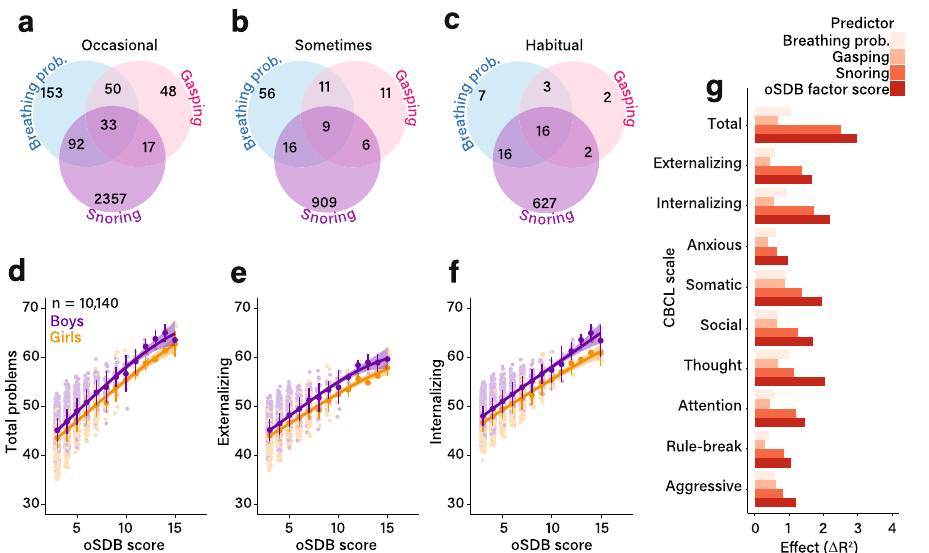
Fig. 1 Relationship between symptom burden of obstructive sleep disordered breathing (oSDB) and Child Behavior Checklist scores. a – c show the prevalence of parent-reported frequency of symptoms of obstructive sleep disordered breathing in the Adolescent Brain and Cognitive Development Study ( n = 10,140). Venn diagrams show the number of children with each symptom in non-intersecting areas or in combination with other symptoms in the intersecting areas. The frequency of symptoms was categorized as occasional ( a , once or twice a month), sometimes ( b , once or twice a week) or habitual ( c , >2 nights a week). The relationship between oSDB burden measured by the sleep-related breathing disorders subscale within the Sleep Disturbance Scale for Children and the three composite measures (total, externalizing, and internalizing problems) from the Child Behavior Checklist (CBCL) was assessed using generalized additive models. Models were adjusted for age, sex, race/ethnicity, the presence of asthma and total household income before taxes as fi xed effects and study site as a random effect. d – f The relationship between the oSDB factor score and the predicted marginal values of three CBCL scales — total, externalizing, and internalizing problems, respectively. The adjusted distributions were fi tted with a smoothing spline, with the error bars spanning one standard deviation around the mean predicted value of each composite CBCL measure with increasing oSDB score grouped by sex. g compares the effects of the parent-reported frequency of oSDB symptoms (e.g., snoring frequency) on problem behaviors by measuring the change in the overall proportion of variance in the generalized additive model following their addition to the null, covariates-only model. The null model comprised solely of fi xed effect (age, sex, race/ethnicity, asthma, and total household income before taxes) and random effect (recruitment site) covariates. The comparisons of the base and covariate-adjusted models using analysis of variance yielded statistically signi fi cant results for all CBCL categories (two-sided P < 10 − 16 , unadjusted for multiple comparisons). The greatest effect was identi fi ed for the relationship between the oSDB symptom score and total problems. Among the individual symptoms, the frequency of snoring predicted CBCL scores better than others. Source data are provided as a Source Data fi